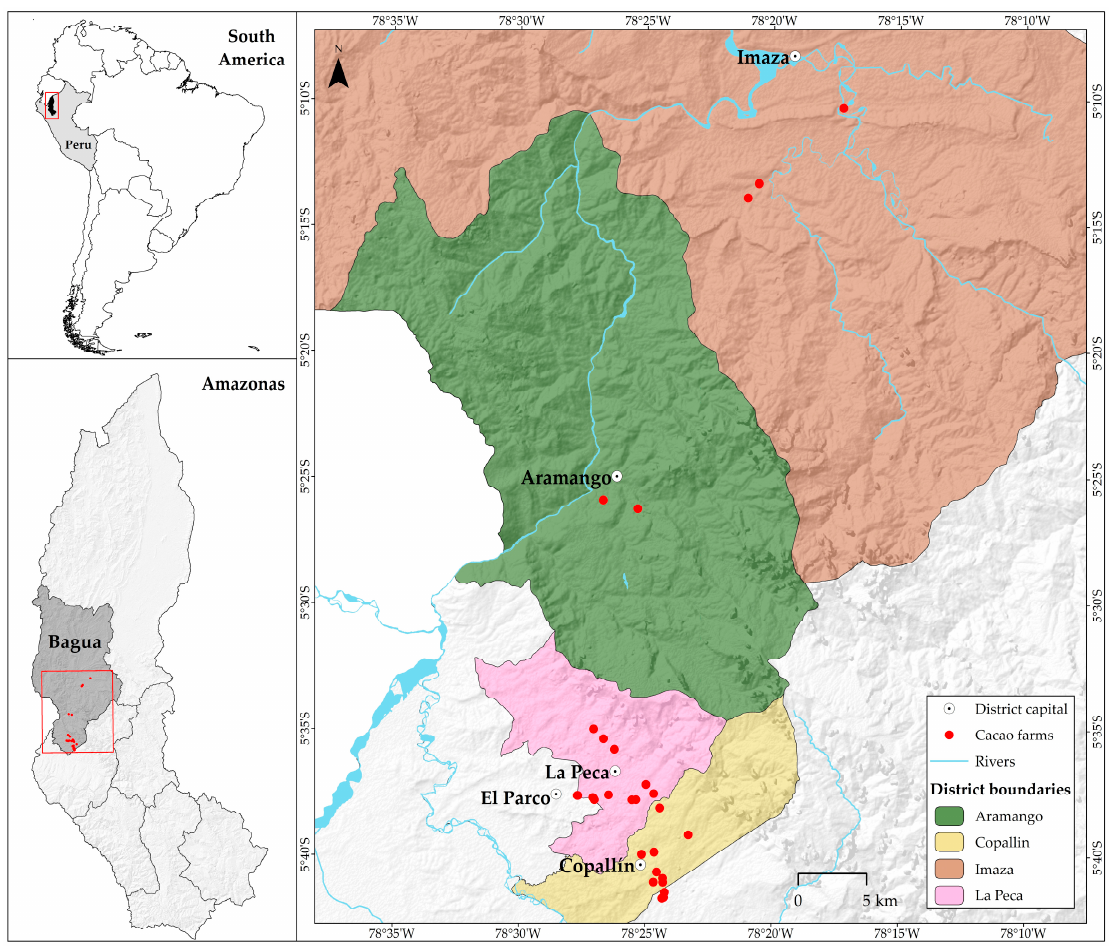
Figure 1. Location of study area and 29 sites within four districts in Bagua, Peru.